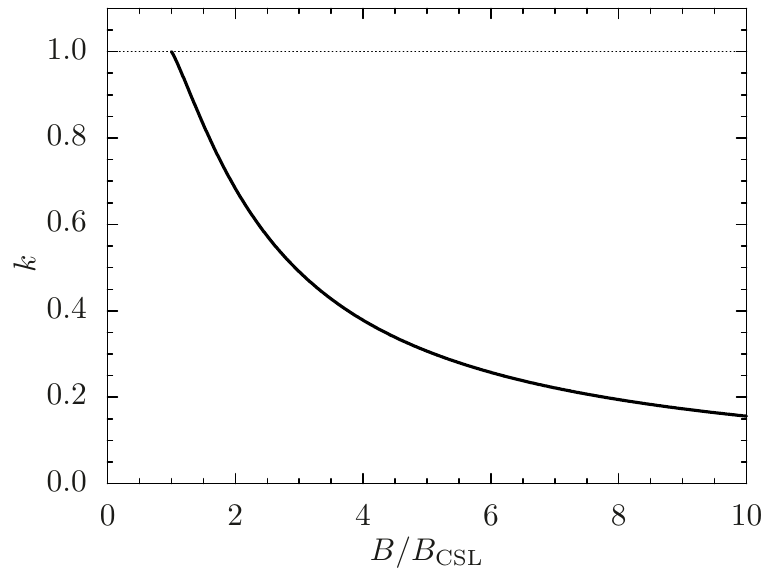
Figure 2 . The value of the elliptic modulus k in the ground state as a function of magnetic (cid:12)eld. where V (cid:17) LS is the volume of the system. Minimization of the total energy E tot at (cid:12)xed volume V with respect to k leads to the simple